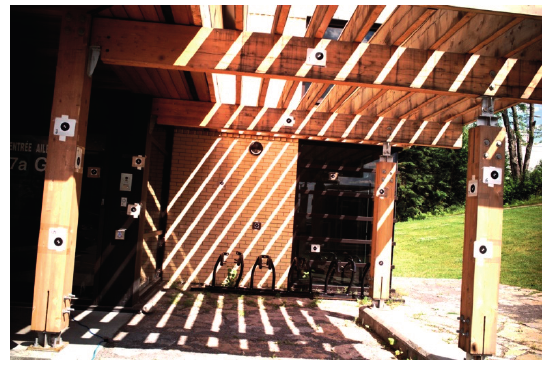
Figure 4. Test-field for platform